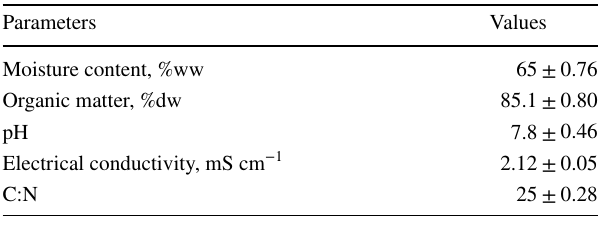
Table 1 Initial parameters of composting chicken manure mixed with sawdust and wood shaving